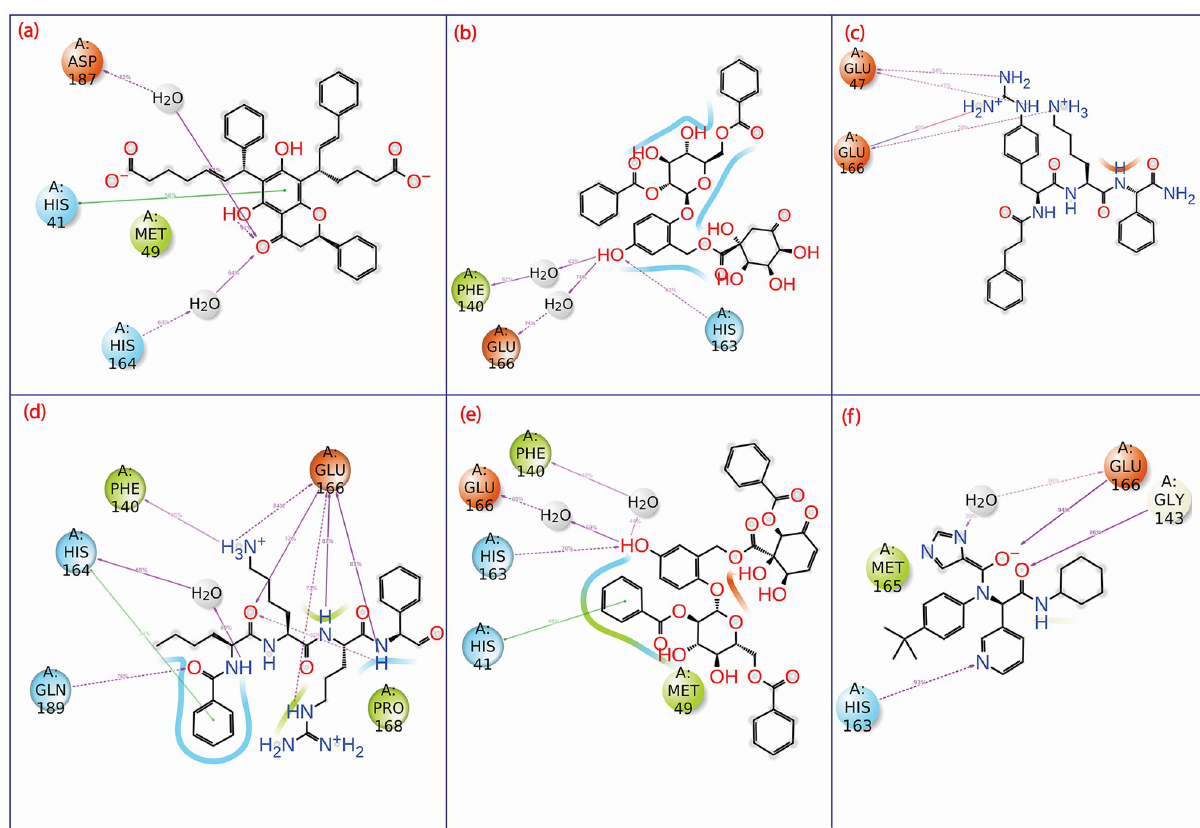
Fig 8. 2D interaction diagram of protein-ligand interactions maps for (a) M pro -CHEMBL1940602 (b) M pro -CHEMBL2036486 (c) M pro - CHEMBL3628485 (d) M pro -CHEMBL200972 (e) M pro -CHEMBL2036488, and (f) M pro -X77 (control), over the 100 ns MD simulation.